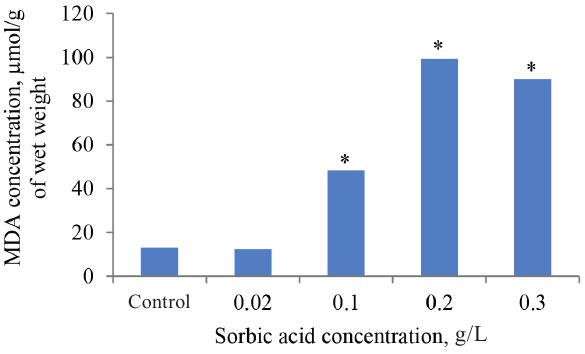
Figure 5 Effects of different doses of sorbic acid on MDA level in roots after 2 days of incubation (n = 10). * P < 0.05